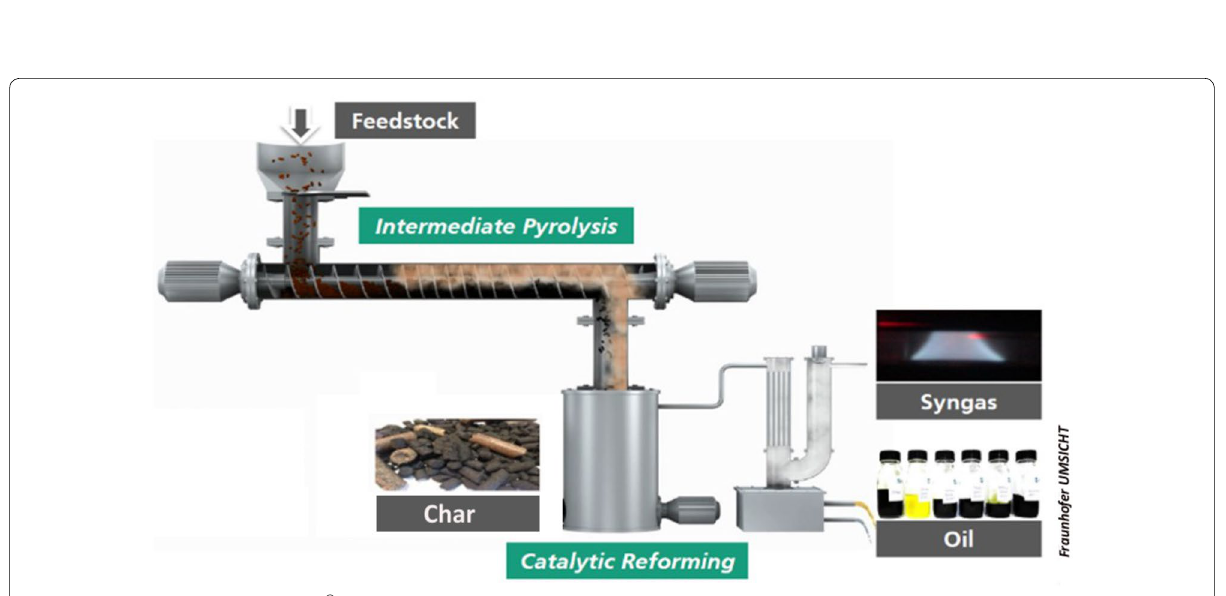
Fig. 2 Schematic principle of the TCR ® process (Jäger et al.